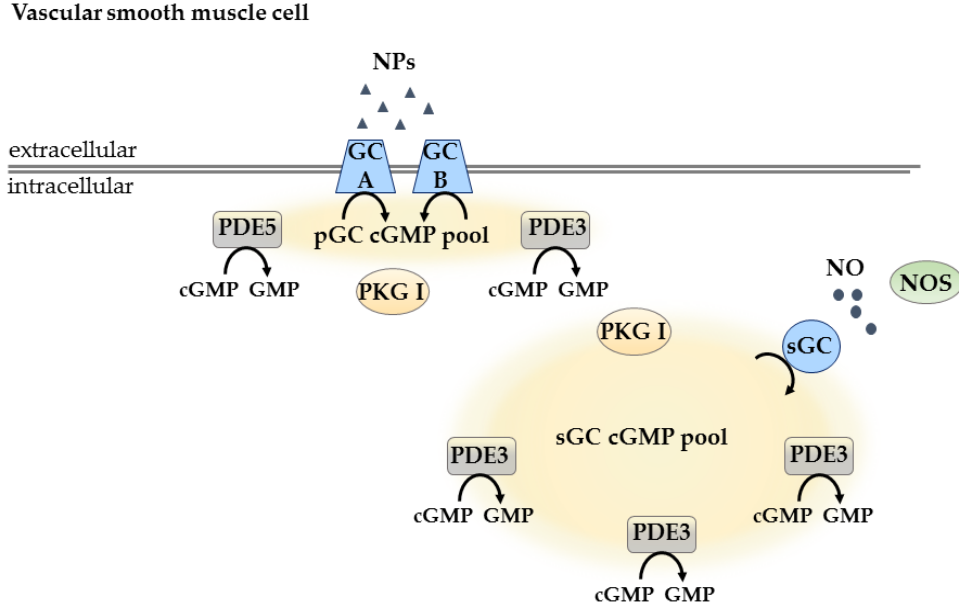
Figure 2. cGMP compartmentation in VSCMs. In VSMCs, there are two different cGMP pools: the pGC/cGMP pool, which is controlled by PDE5 and PDE3, and the sGC/cGMP pool, which is mainly regulated by PDE3. Black arrows indicate enzymatic activity.